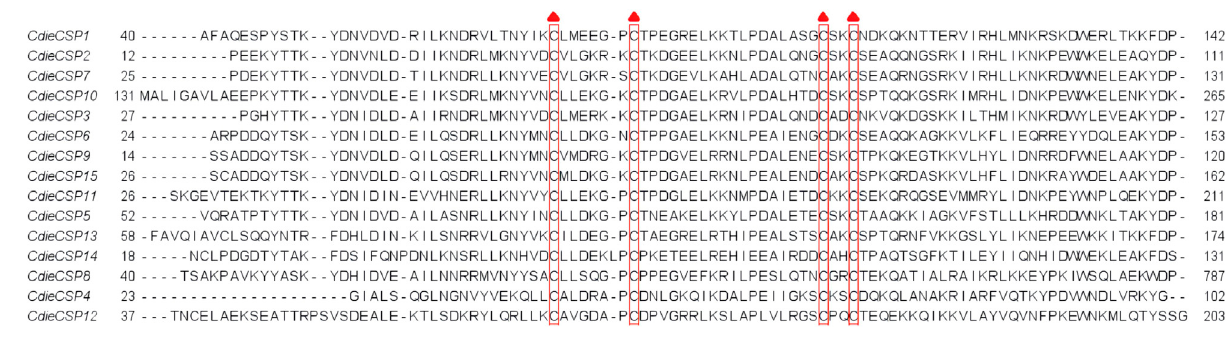
FIGURE 3 | Alignment of candidate CSPs of C. dieckmanni. Each highly conserved cysteine residue is marked with a red triangle above